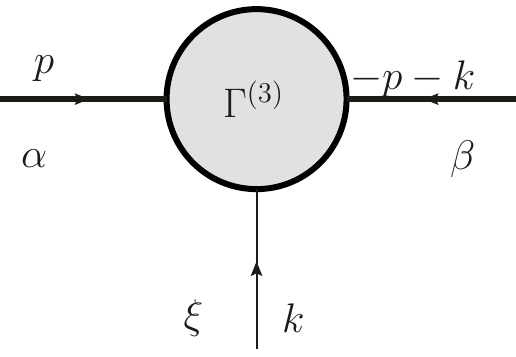
Figure 1 . 1PI vertex involving two (cid:12)nite energy particles and one soft